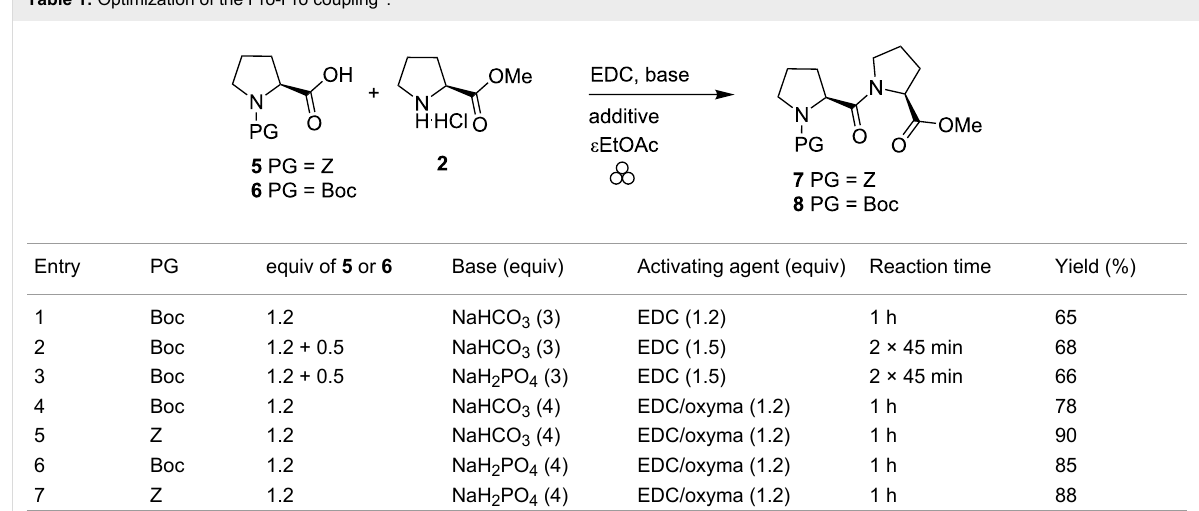
Table 1: Optimization of the Pro-Pro coupling a